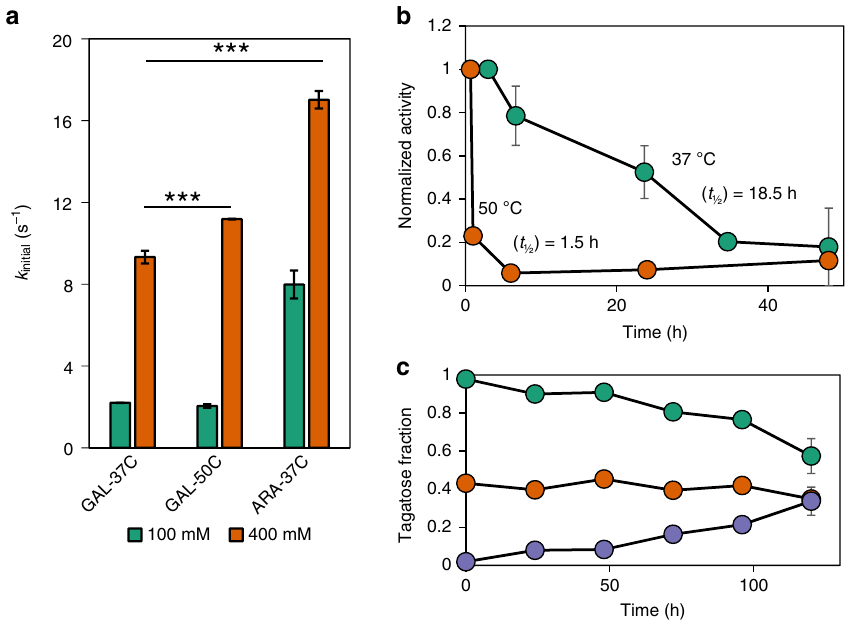
Fig. 1 Assessing the limitations of free-enzyme LsLAI. a Initial turnover rates of puri fi ed LsLAI compared at medium (100 mM, green) and high (400 mM, orange) substrate loading at low (37 °C) and elevated (50 °C) temperatures. Comparison of the non-native substrate, galactose at low (GAL-37C) and high (GAL-50C) temperature, to that of native substrate, arabinose at low temperature (ARA-37C). b Loss of activity of puri fi ed LsLAI over time incubated at 37 °C (green) or 50 °C (orange). Half-life calculated from fi rst-order decay equation. c Equilibrium conversion of puri fi ed LsLAI starting from 10 mM total substrate with galactose to tagatose ratio at 1:0 (10 mM galactose, purple), 1:1 (5 mM each galactose and tagatose, orange), or 0:1 (10 mM tagatose, green) incubated at 37 °C. Additional enzyme was added every 24 h to account for thermal inactivation. The data are means from three independent biological replicates ( n = 3). *** = p < 0.001 (Students t -test). Source data are provided as a Source Data fi le